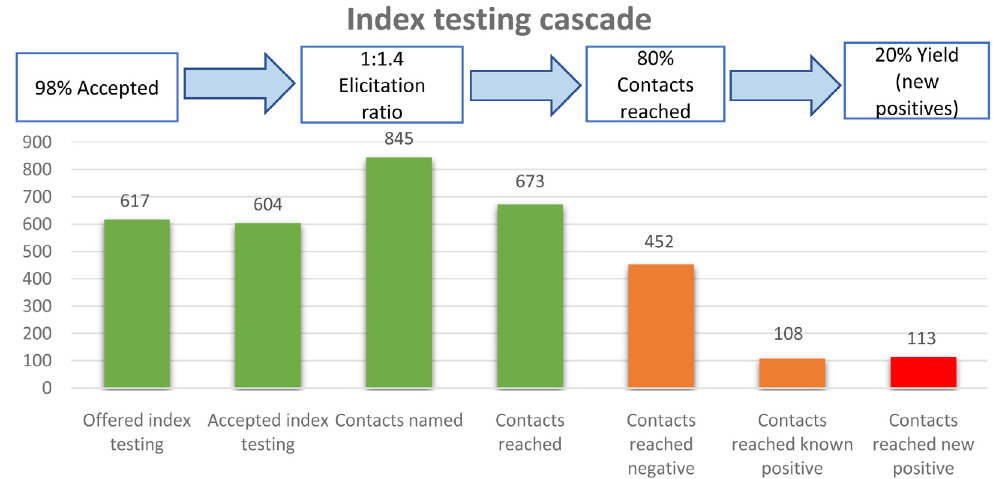
Figure 1. Index testing